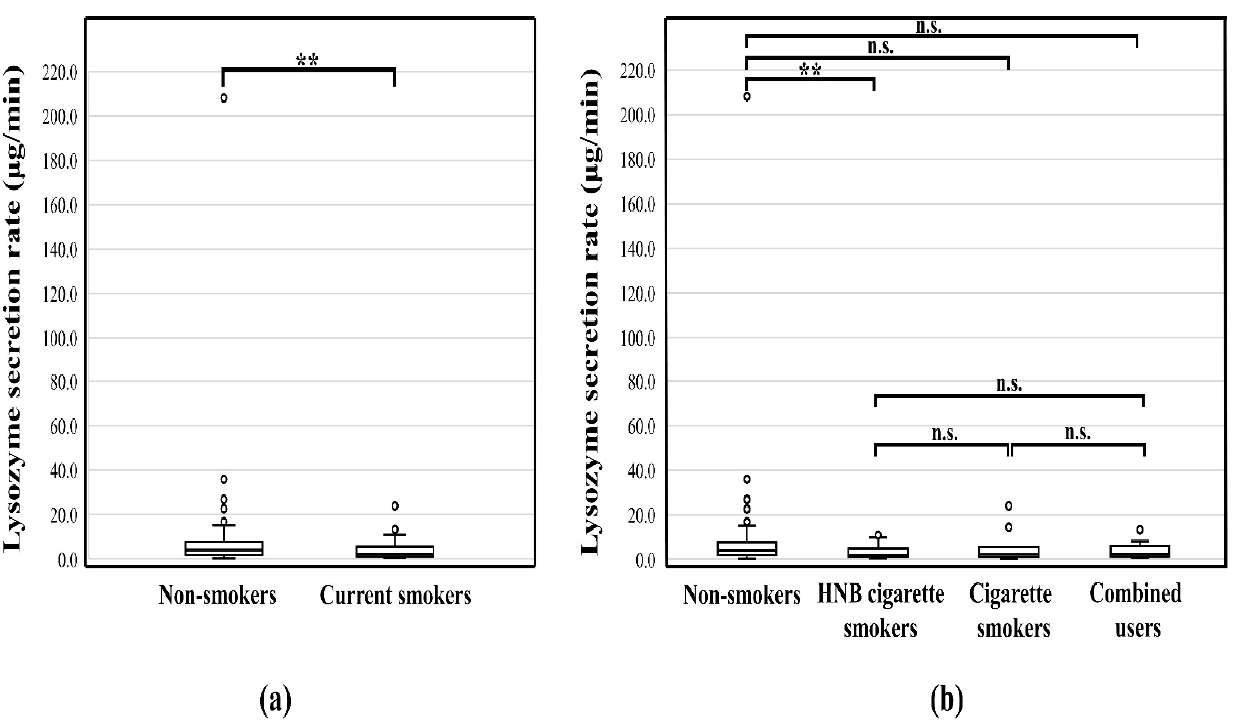
Figure 3. ( a ) Comparison of the rate of lysozyme secretion in non-smokers and smokers; ( b ) Comparison of the rate of lysozyme secretion by different smoking devices; **, p < 0.01; n.s., no significant difference; HNB, Heat-not-burn.